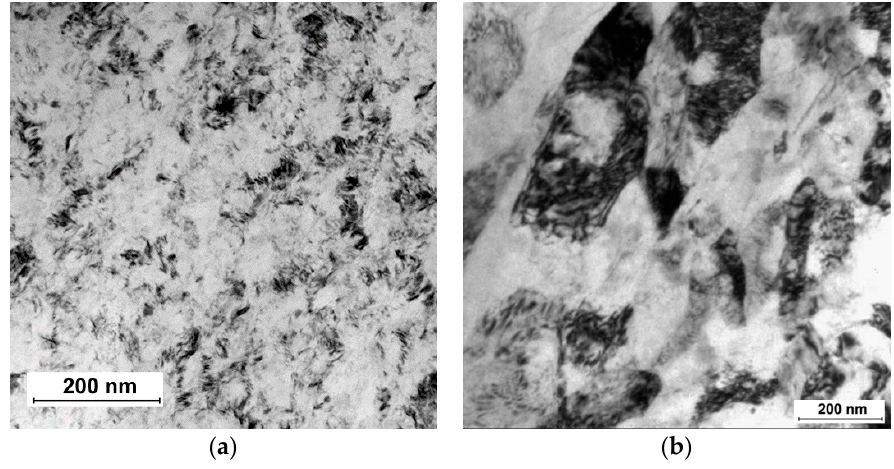
Figure 4. Microstructure of ( a ) Ti15Mo alloy prepared by HPT and ( b ) Ti-35Nb-6Ta-7ZZr alloy prepared by ECAP (cross-section).